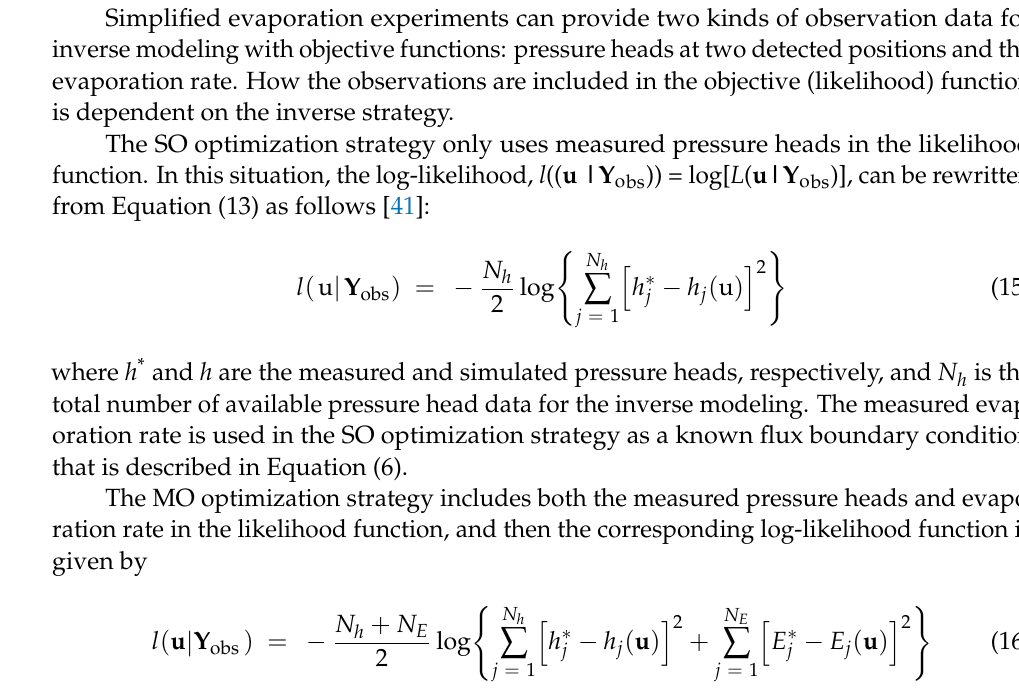
Table 1. Reference soil parameters extracted from the HYDRUS-1D catalog to generate the three synthetic experiments. Soil Type θ S θ r α Sand Loam